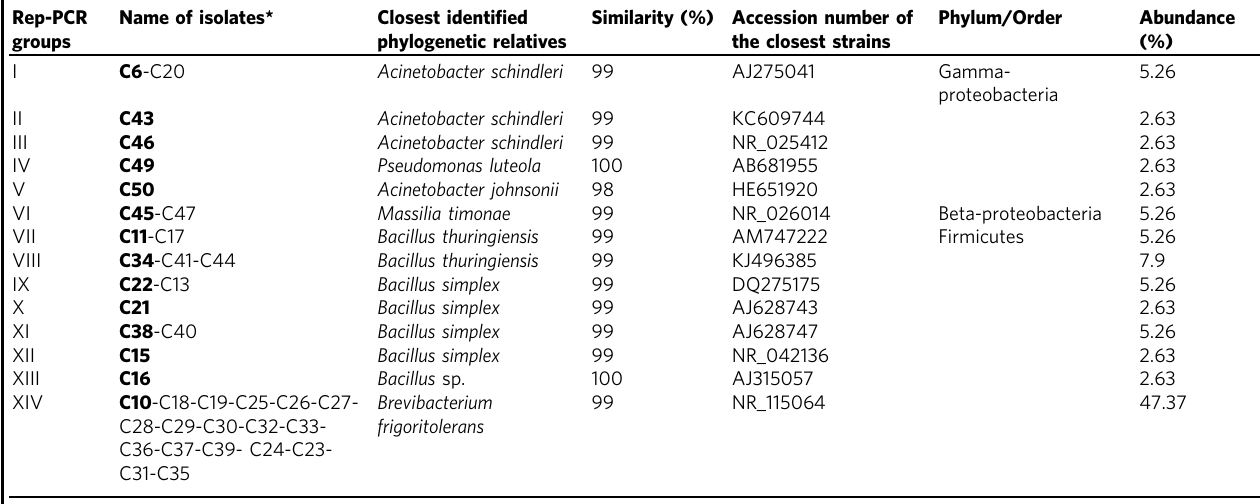
Table 1 Phylogenetic classi fi cation of the bacterial community activated with the M-3P nutritive solution and used as inoculant for the bio-consolidation treatment in San Jeronimo Monastery Rep-PCR